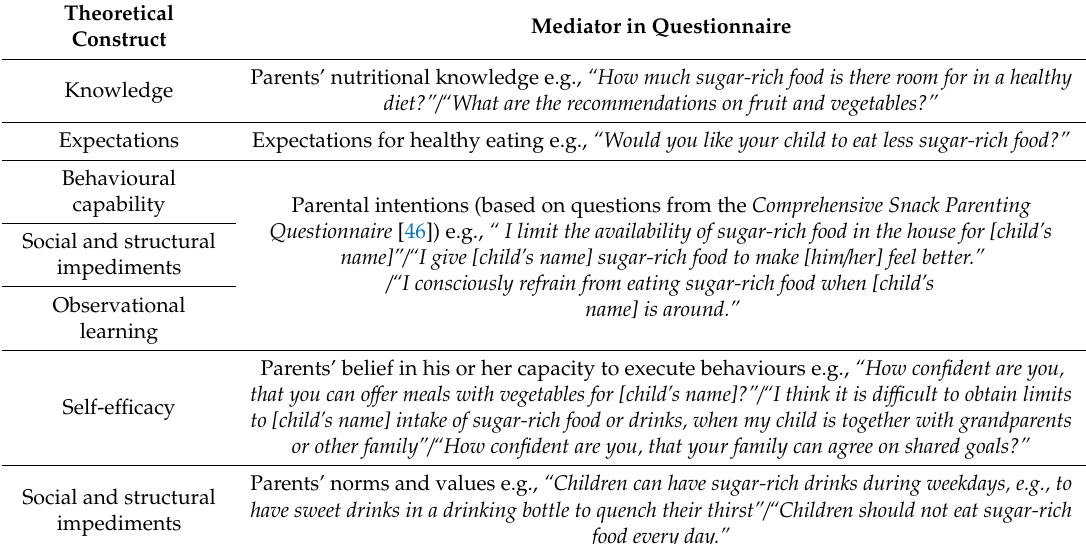
Table 2. Overview of the theoretical construct of the